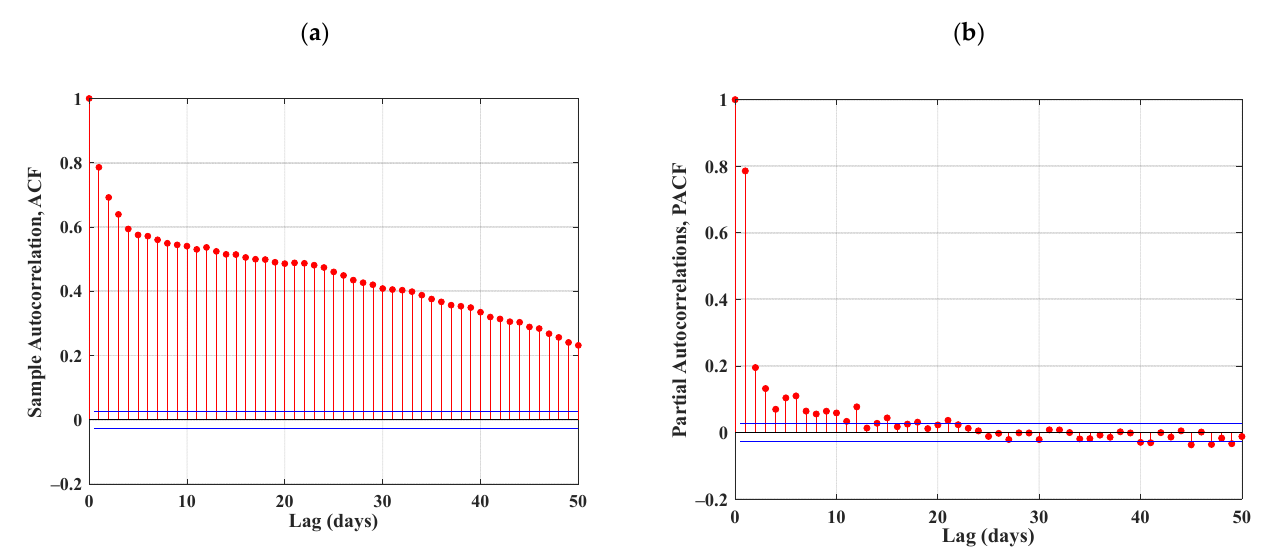
Figure 6. ACF ( a ) and PACF ( b ) plots of the ET 0 time series for 50 lags at Gazipur station.